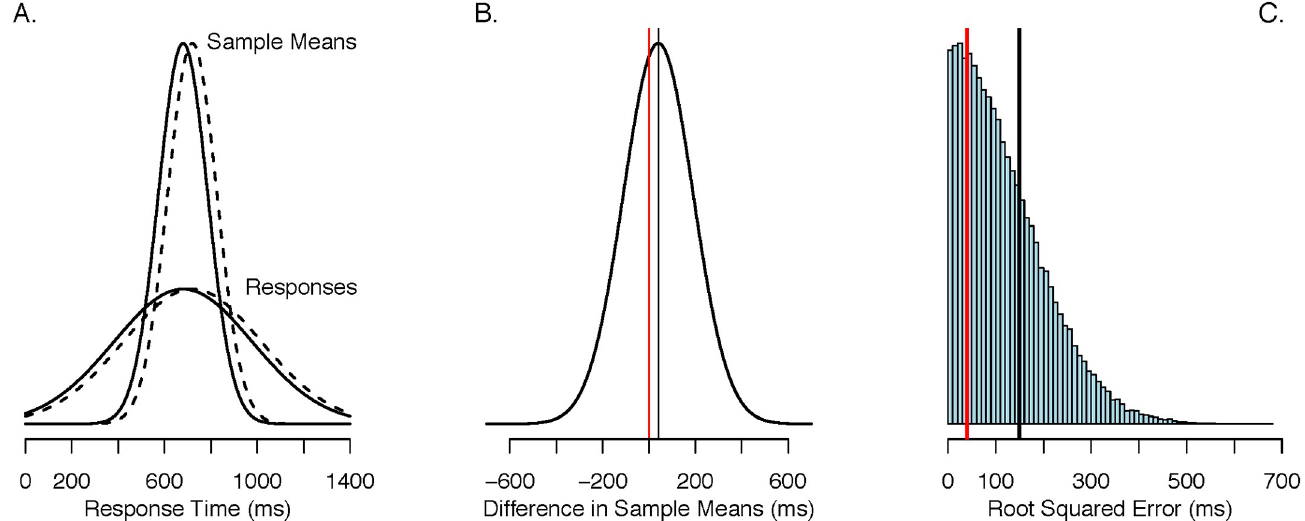
Fig 1. Estimators and error. A . Distributions of observations and sample means across 8 observations for the African American actor condition (solid line) and White actor condition (dashed-line). B . Distribution of the measurement tool, the difference in sample means. The vertical line is the zero estimator. C . Distribution of the absolute error for the sample mean measurement tool. The root-mean-squared error is 7 times greater for the sample mean tool than the zero estimator.